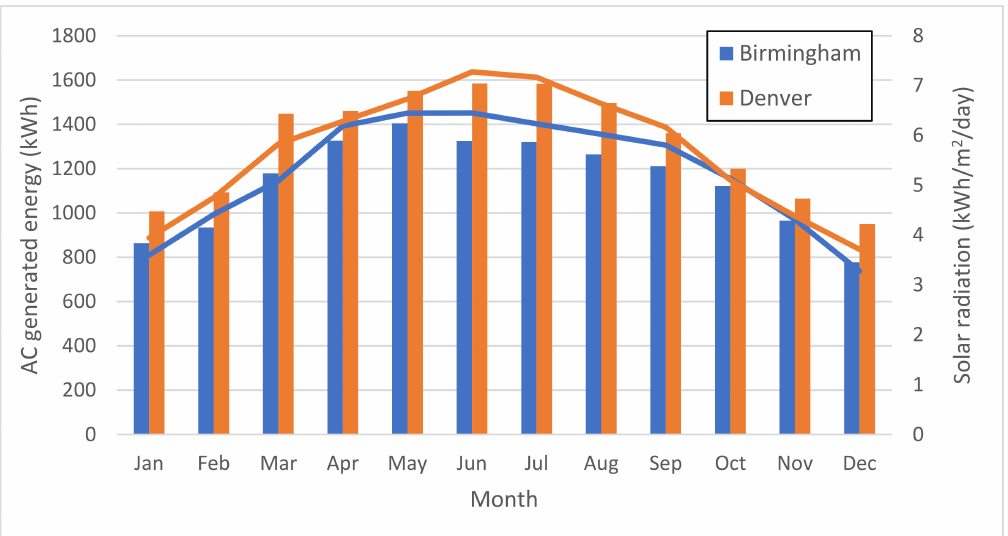
Figure 5. Monthly simulated AC energy output of the PV system in Birmingham and Denver along with the corresponding magnitude of solar radiation. Bar plots show the generated power, and line plots show the solar radiation.